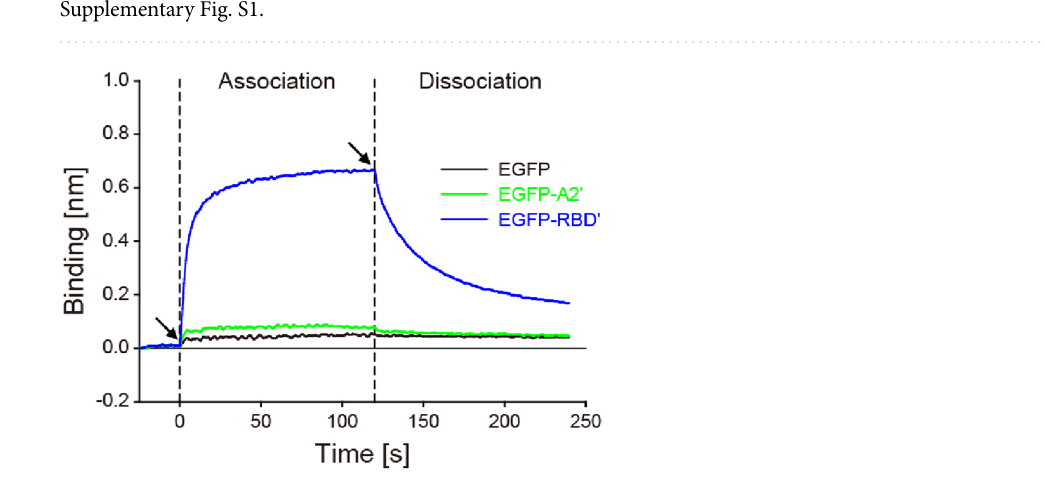
Figure 3. Characterization of SV2C-LD-association/dissociation of the recombinant peptides using bio-layer interferometry. Left and right arrows indicate the initial points of association and dissociation,